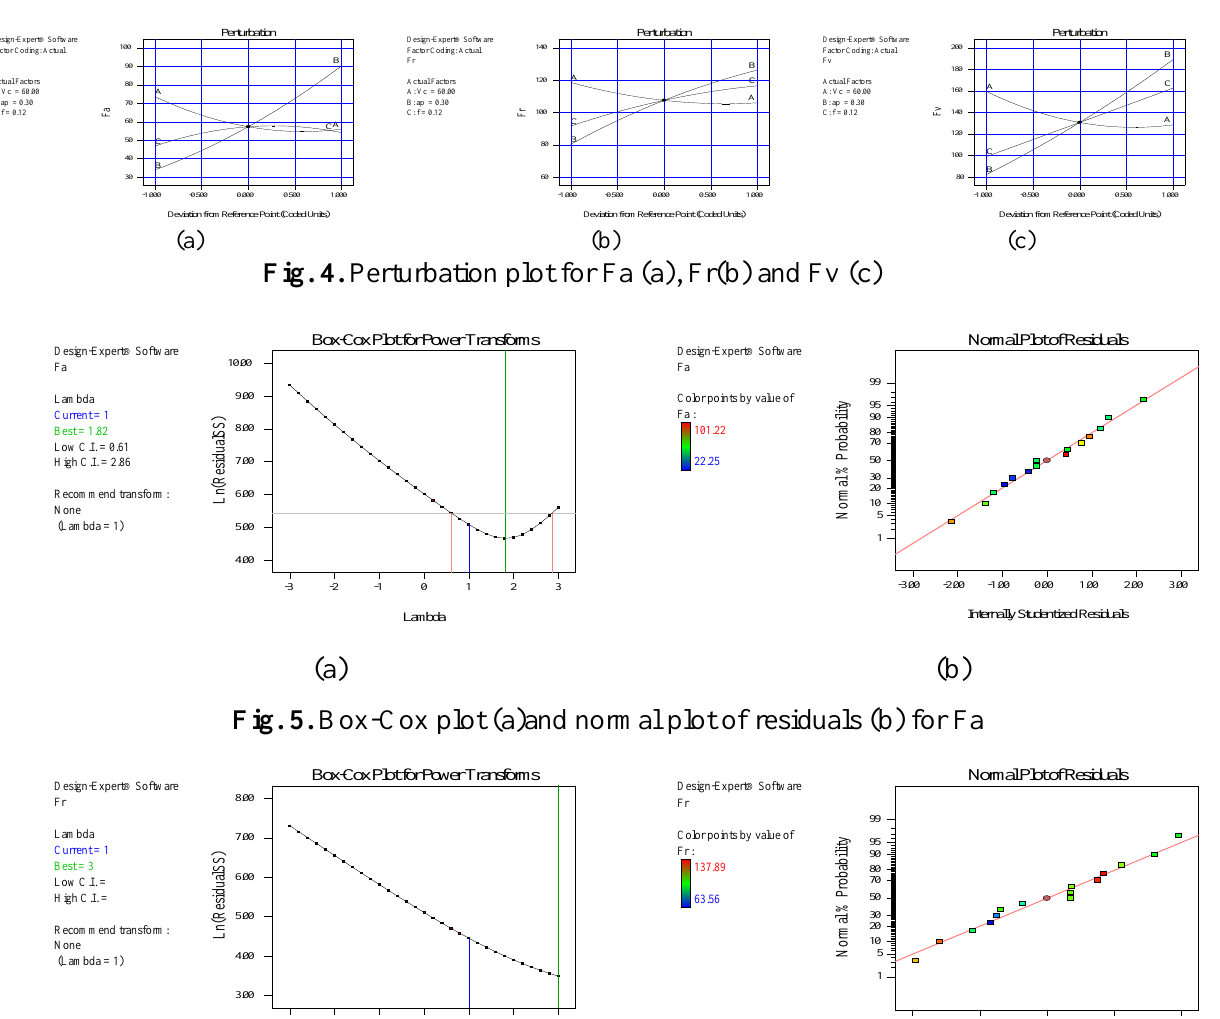
Fig. 4. Perturbation plot for Fa (a), Fr(b) and Fv (c)